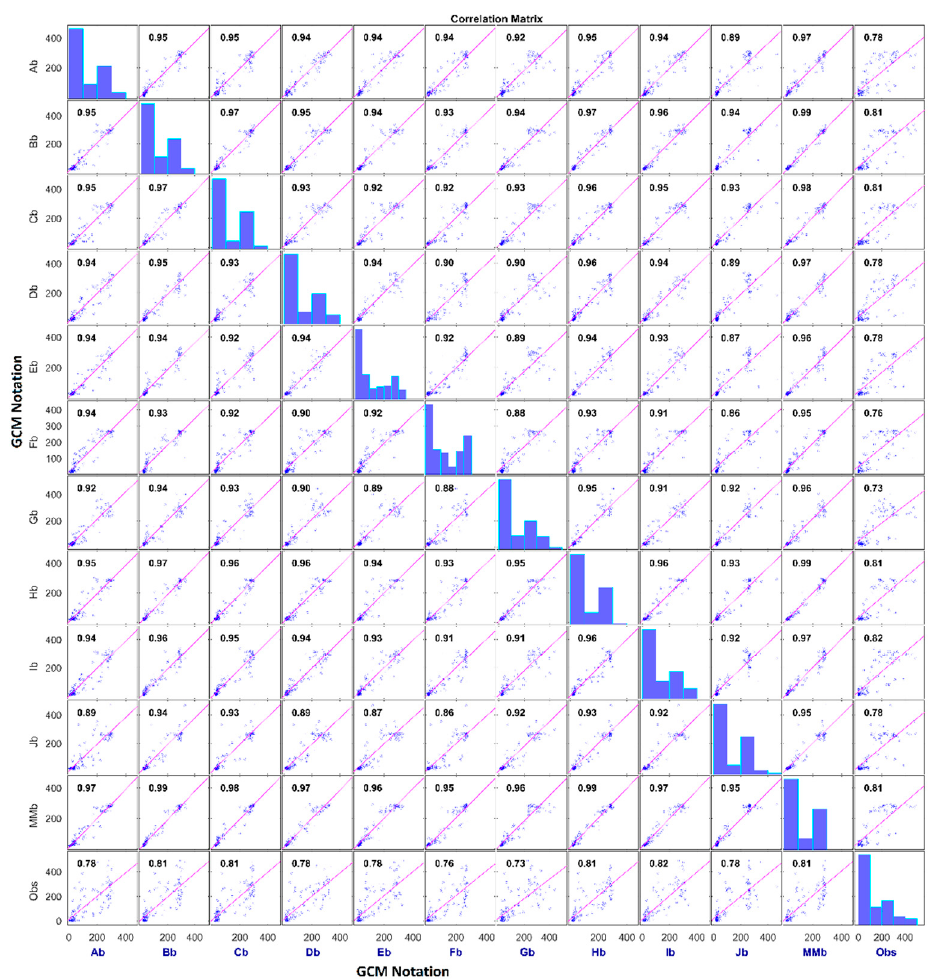
Figure 18. Correlation matrix of downscaled precipitation for different GCMs with the GCM-Obs model for Zone-4. Markings are the same ones as given in Figure 17.